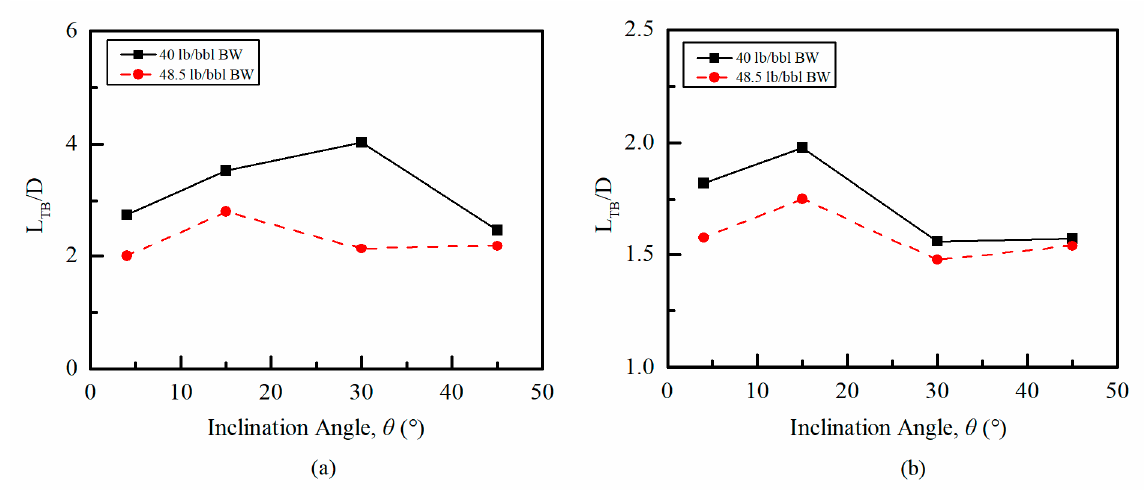
Figure 20. Influence of liquid viscosity on the (cid:1838) (cid:3021)(cid:3003) . ( a ) (cid:1847) (cid:3013) = 0.218 m/s; ( b ) (cid:1847) (cid:3013) = 0.5